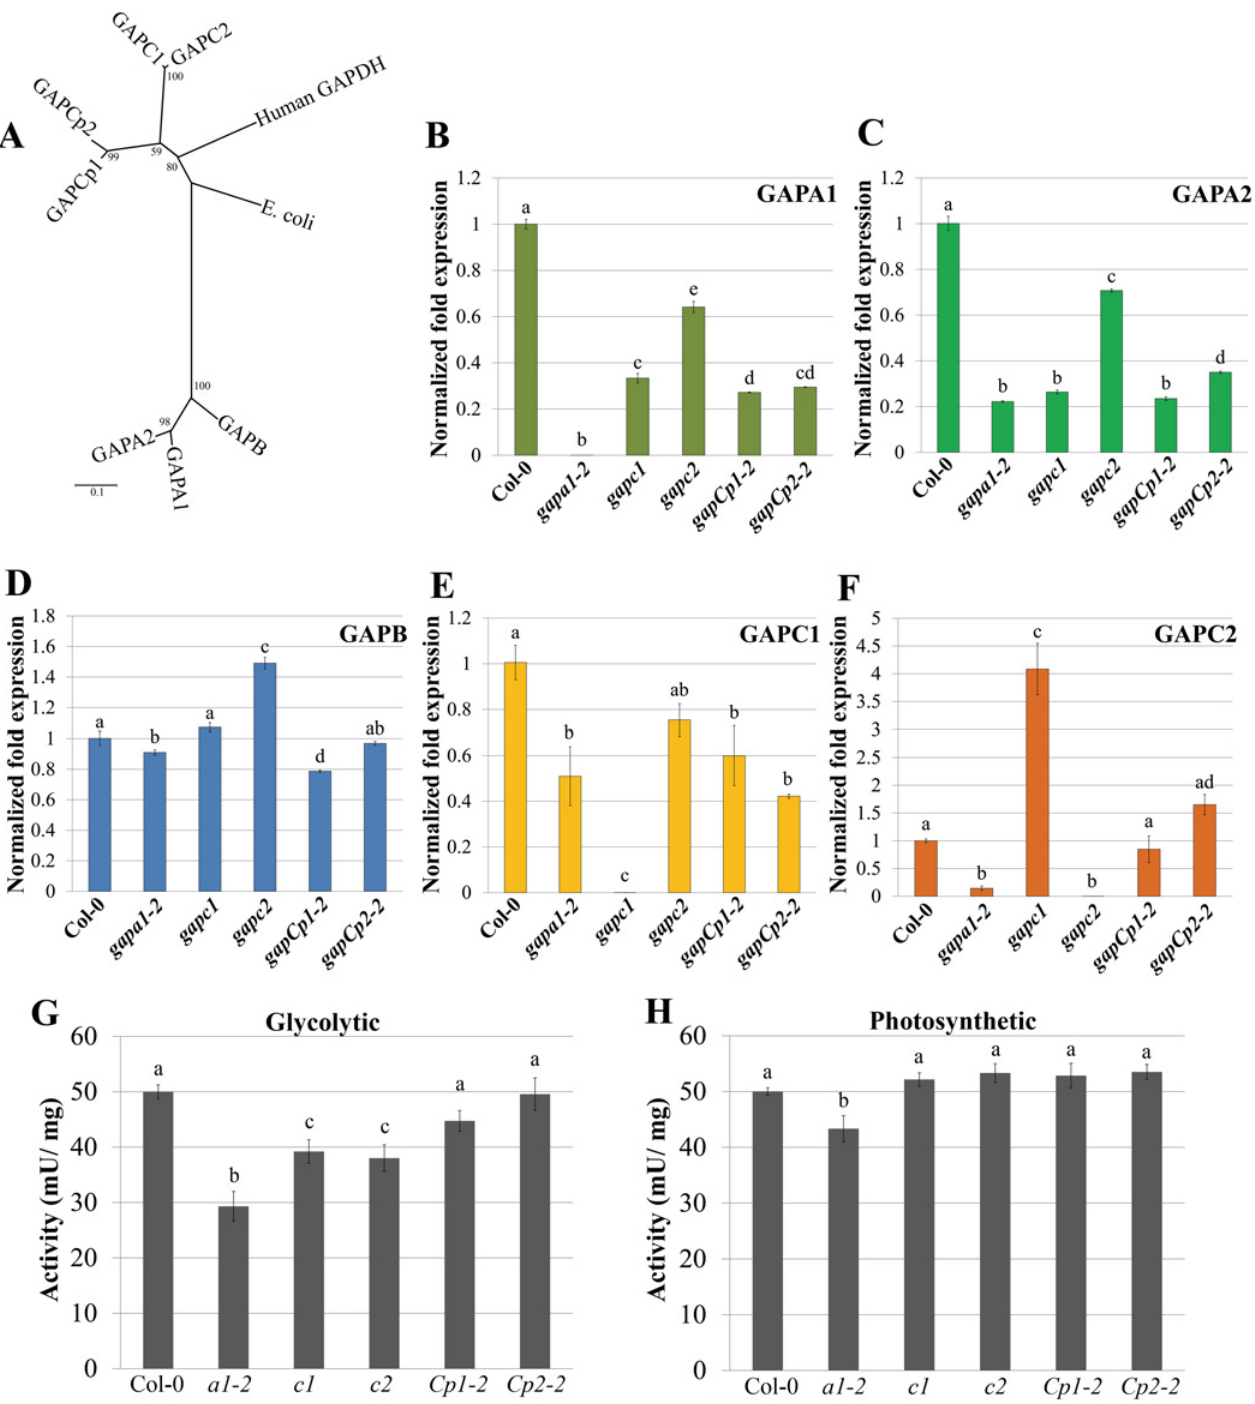
Fig 3. Transcription of GAPDH family members and enzymatic activity are altered in individual GAPDH knockout lines. ( A) Unrooted phylogeny of Arabidopsis phosphorylating GAPDHs as well as human and E . coli GAPDH. Arabidopsis GAPCs and GAPCps cluster with human GAPDH, while photosynthetic GAPDHs cluster separately. Values at nodes indicate bootstrap values. Scale bar indicates the number of amino acid substitutions per site visualized in the branch length. (B-F) Quantitative PCR (qPCR) analyses of leaves from four-week-old plants were used to quantify basal expression levels of phosphorylating GAPDHs across different KO lines. Expression values are shown relative to wild-type Col-0. Data were analyzed using the ΔΔ cT method, and normalized against Arabidopsis ELONGATION FACTOR 1 α (At5g60390). Statistical differences were calculated using Fisher ’ s LSD test ( α = 0.05) following a significant F-statistic. Values represent means ± SE (n = 3). (G) Leaf protein extracts from four-week-old GAPDH KO lines and Col-0 were assayed